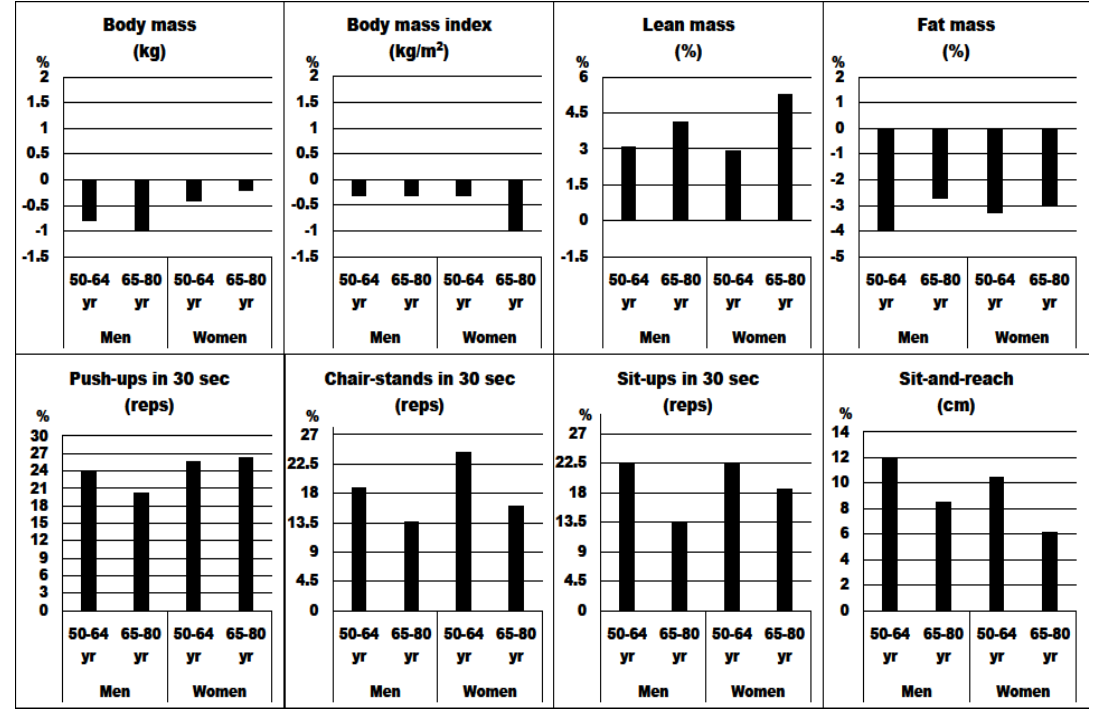
Figure 1. Intervention-induced changes (%) for body composition, muscular fitness, and flexibility before and after the 4-week resistance training across the age groups in years (yr).